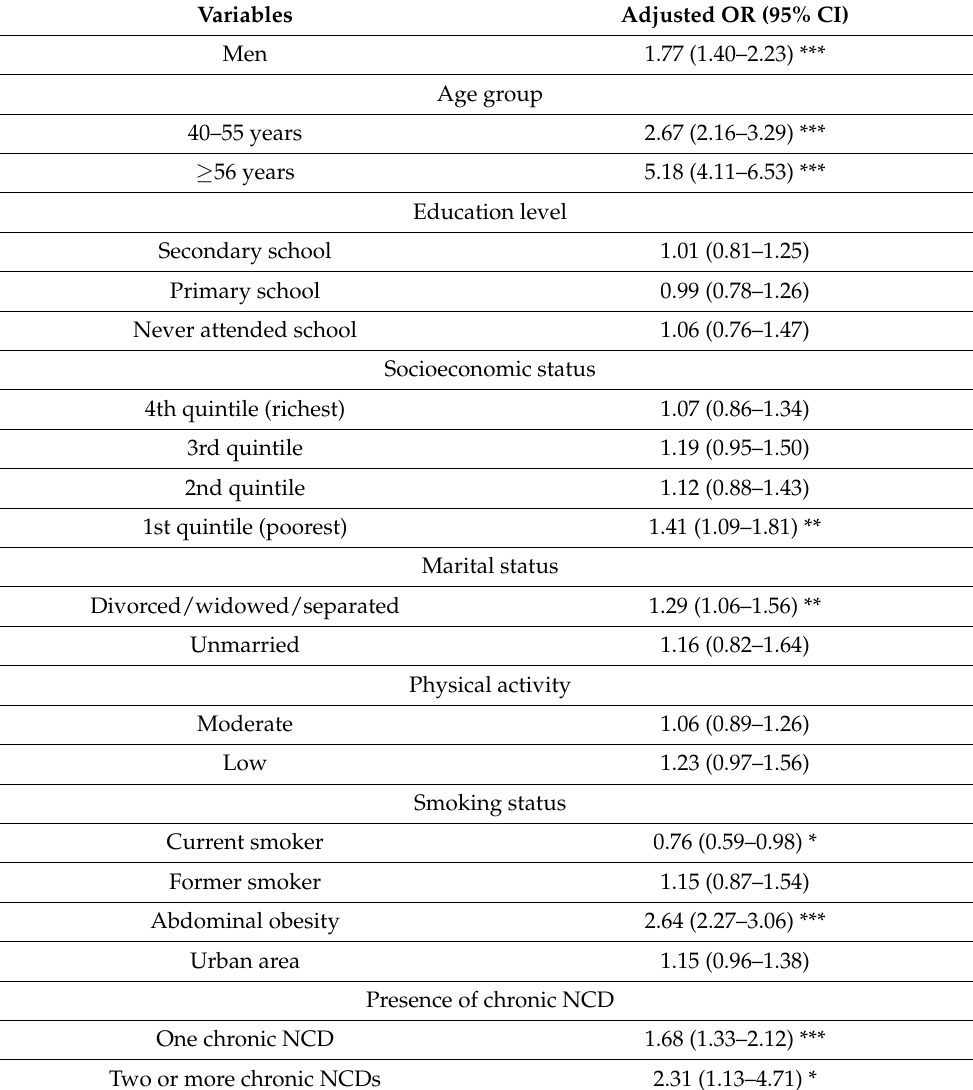
Table 3. The odds of the association between sociodemographic variables, SES, health behavior, and hypertension (in